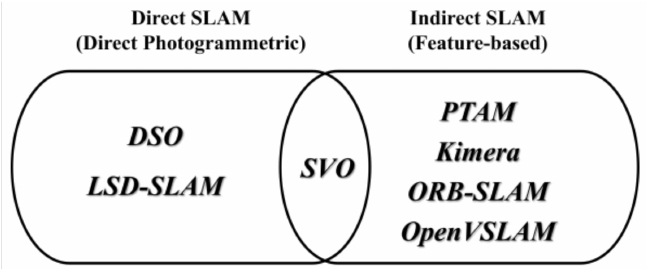
Figure 1. Classification of SLAM algorithms depending on map configuration method.